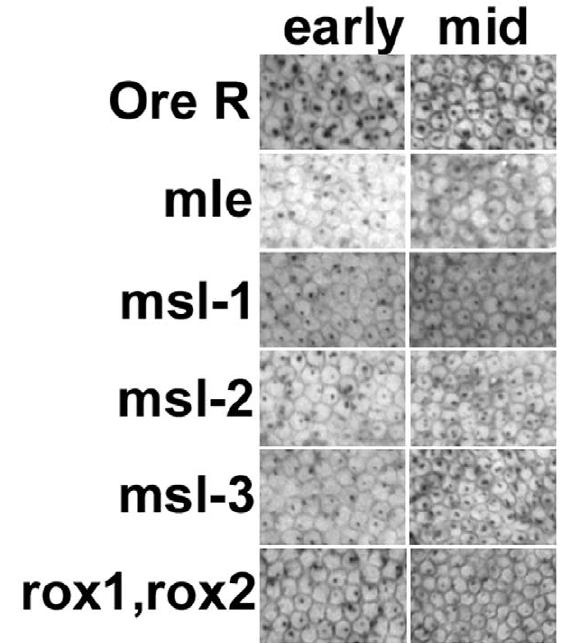
Figure 5. Transcription from the Sxl maintenance promoter, Sxl Pm , is also reduced in embryos homozygous for the msls . In situs of embryos using a Sxl late transcript specific probe during early and mid cycle 14. As cellularization proceeds during cycle 14, the membranes between the nuclei drop into the embryo, the cell volume changes allowing embryo staging. Only females are shown. Male embryos also transcribe Sxl Pm – single X chromosome dots – not shown. All embryos photographed at 40 6 mag.